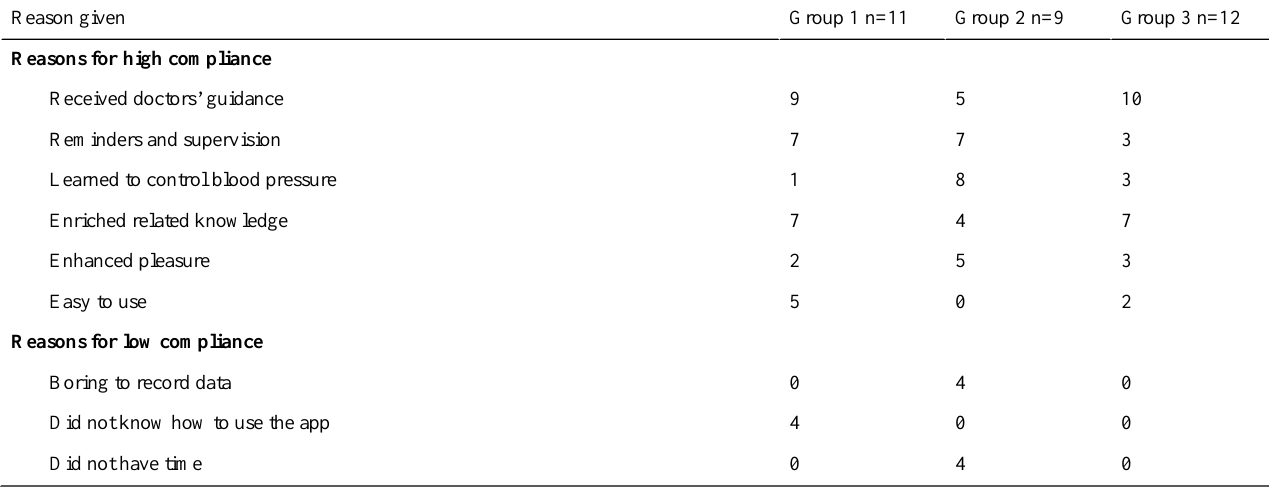
Table 8. Reasons for patient compliance from the